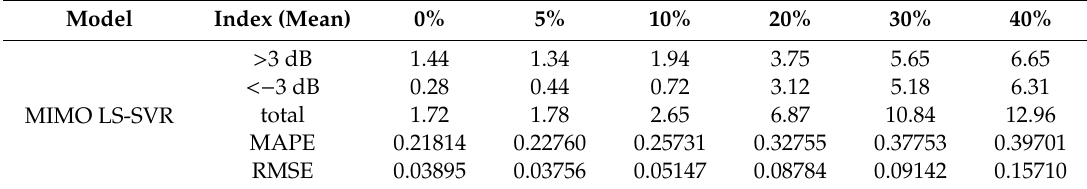
Table 6. Performance of the MIMO LS-SVR model under di ff erent level of noise.